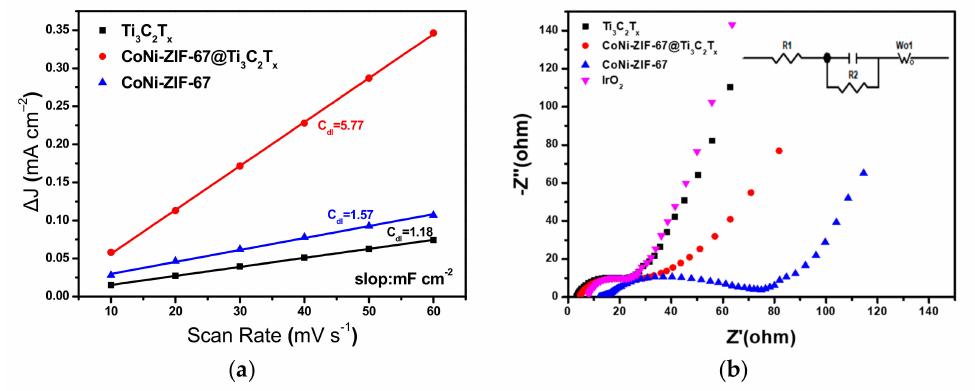
Figure 6. ( a ) ∆ J = ( J a − J c) plotted scan rates and ( b ) Nyquist plots for di ff erent catalysts.